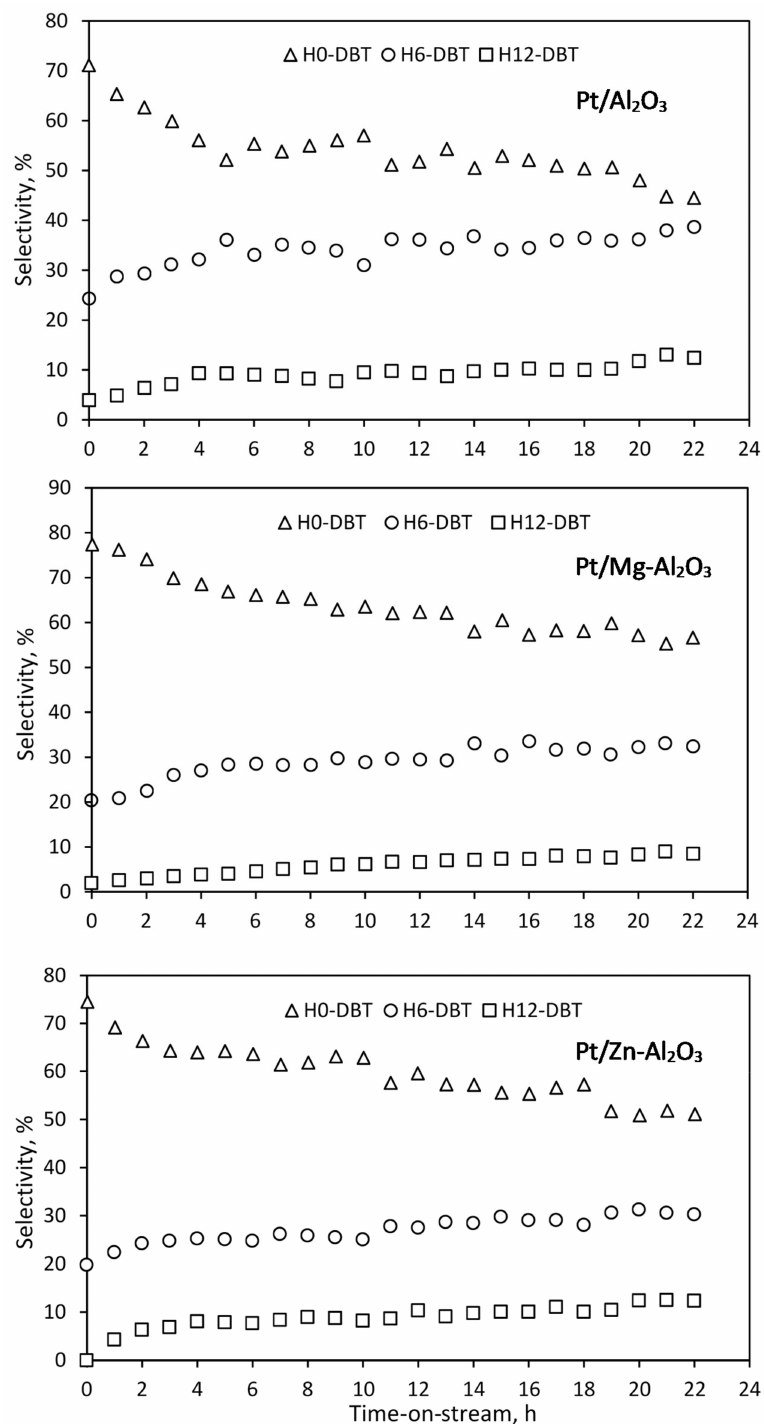
Figure 4. Selectivity of the catalysts to H0-DBT, H6-DBT and H12 DBT over 22 h time-on-stream. Reaction parameters: Pt loading 0.5 wt.%, H18-DBT doh 99.6%, reaction temperature 300 ◦ C, feed flow 1.3 mL/min, catalyst mass 110 g, weight hourly space velocity 0.61 h − 1